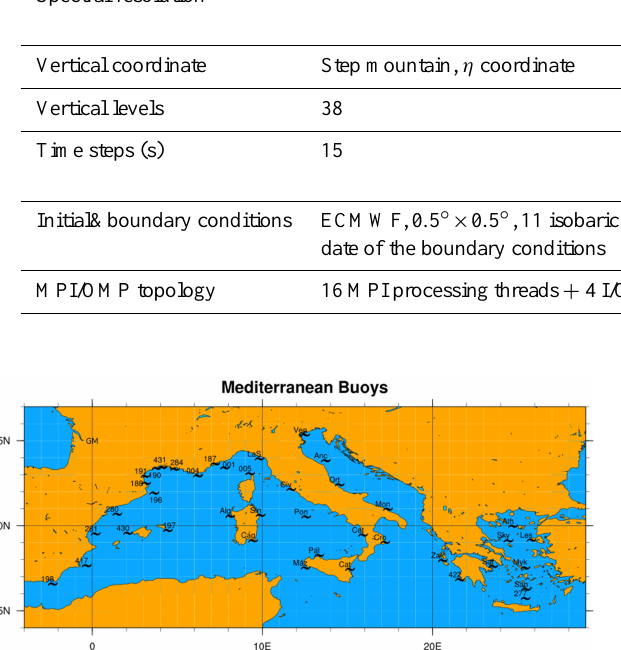
Figure 8. Spatial distribution of the Mediterranean buoys applied for the sensitivity test of the system. Data were made available from ISPRA in the framework of MyWave